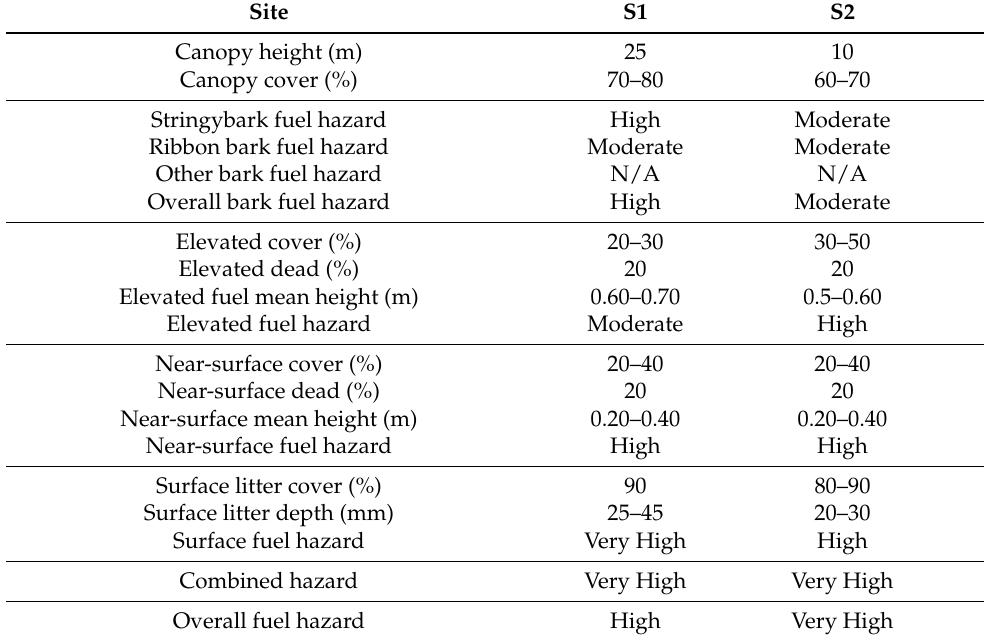
Table A1. Overall fuel hazard ratings for S1 and S2, following the methodology developed by Hines et al.